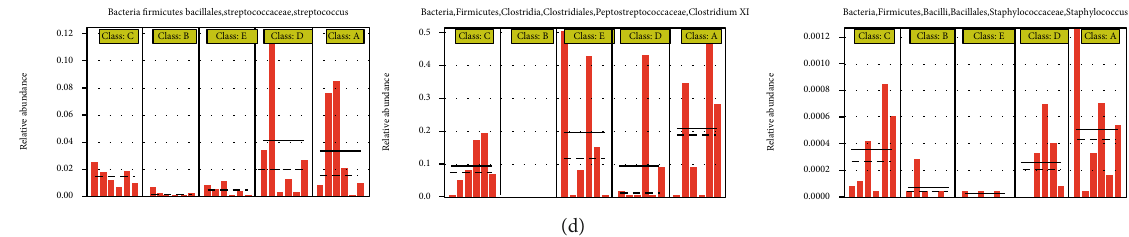
Figure 1: E ff ects of Bacillus subtilis PB6 on the intestinal bacterial structure in broilers challenged with Clostridium perfringens . (a) Venn diagrams showing the shared OTUs between the fi ve di ff erent treatments. (b) E ff ects of relative abundance (%) of ileal bacterial taxa at the phylum level of broilers. (c) Relative abundance (%) of ileal bacterial taxa at the genus level of broilers. (d) The relative abundance (%) of ileal bacterial taxa at the genus level of Streptococcus , Clostridium XI , and Staphylococcus in broilers. Treatment information: A: basal diet; B: basal diet and CP challenge; C: CP challenge+10 mg/kg enramycin (positive control group); D: CP challenge+ 4 × 10 7 CFU/kg of feed B . subtilis PB6 (PB6 low-dosage group); E: CP challenge+ 6 × 10 7 CFU/kg of feed B . subtilis PB6 (PB6 high-dosage